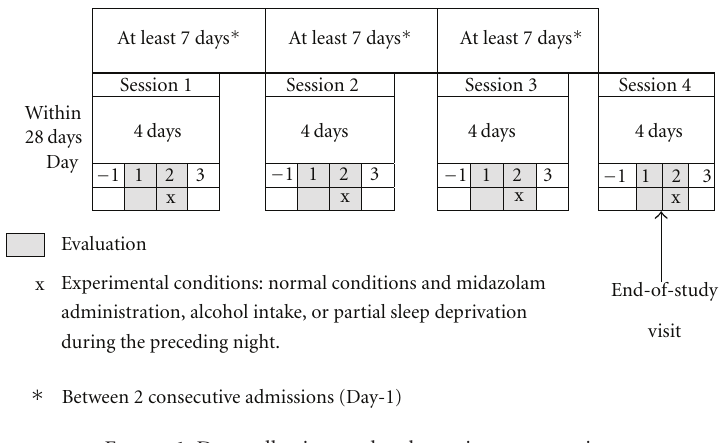
Figure 1: Data collection study schematic